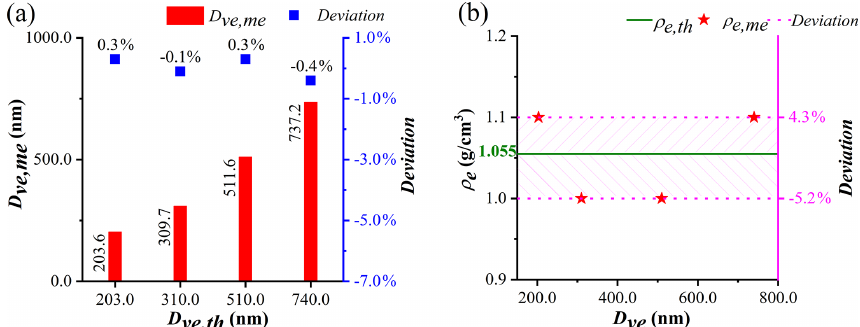
Figure 2. (a) Comparison between the measured D ve (D ve , me ) and the theoretical D ve (D ve , th ) of the PSL particles. (b) Comparison between the measured ρ e ( ρ e , me ) and the theoretical ρ e ( ρ e , th ) of the PSL particles.